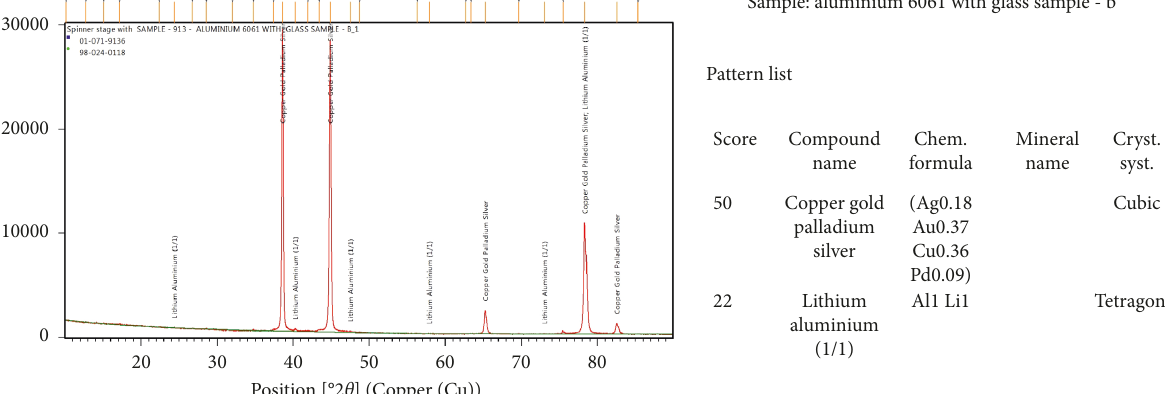
Figure 6: X-ray diffraction analysis pattern of 5% of reinforcement with glass